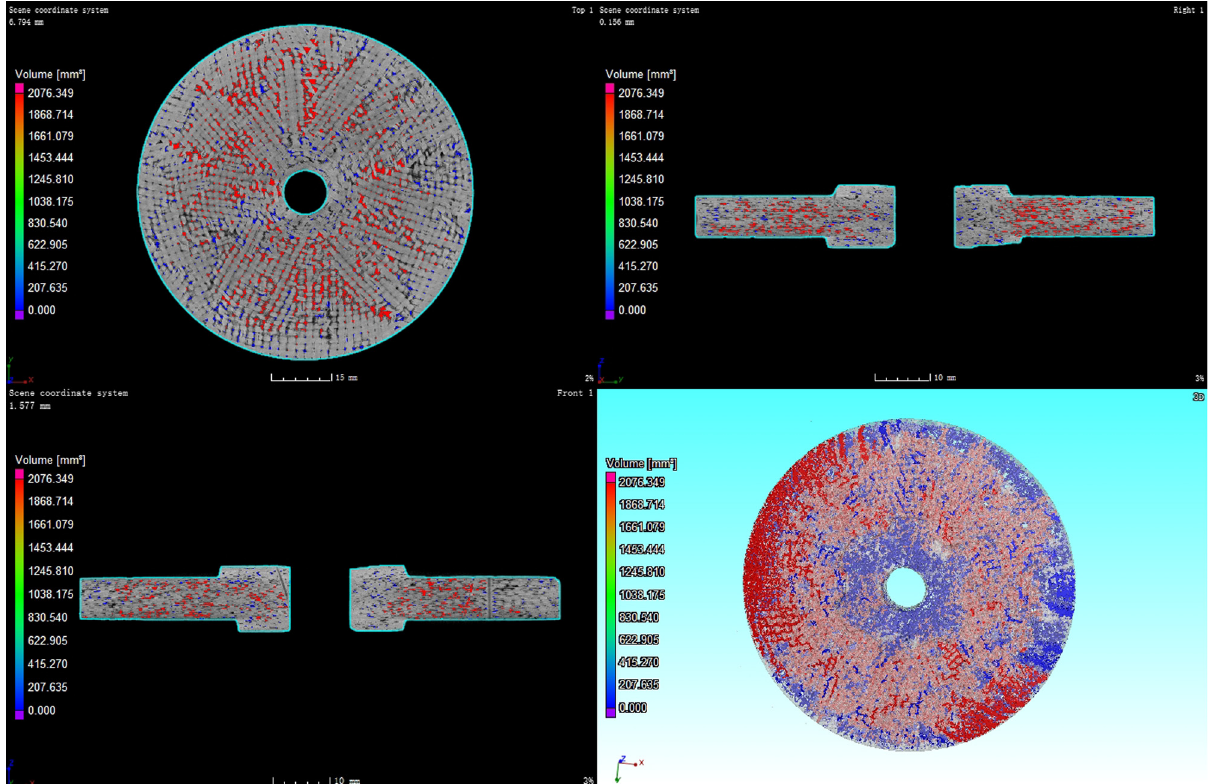
Figure 11: Internal defect analysis of SWS - SiC/SiC turbine blisk using micro - CT